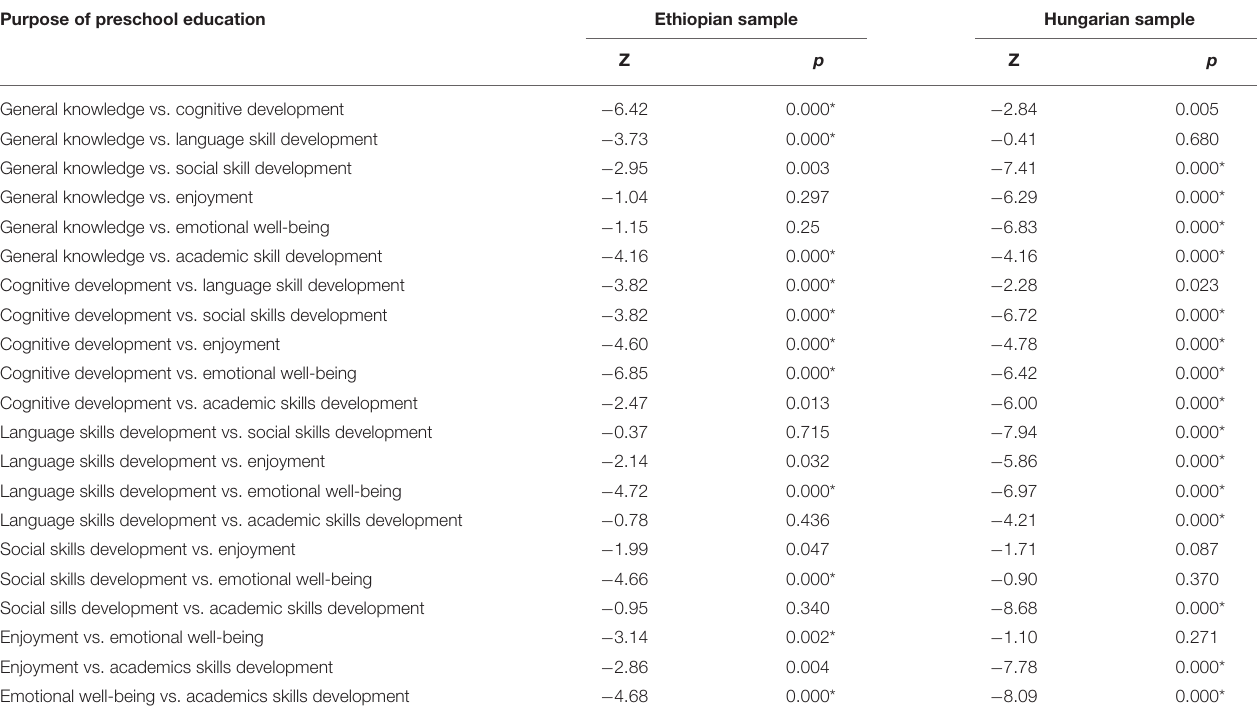
TABLE 5 | Summary of Wilcoxon signed-ranks test using the Z statistic and significance